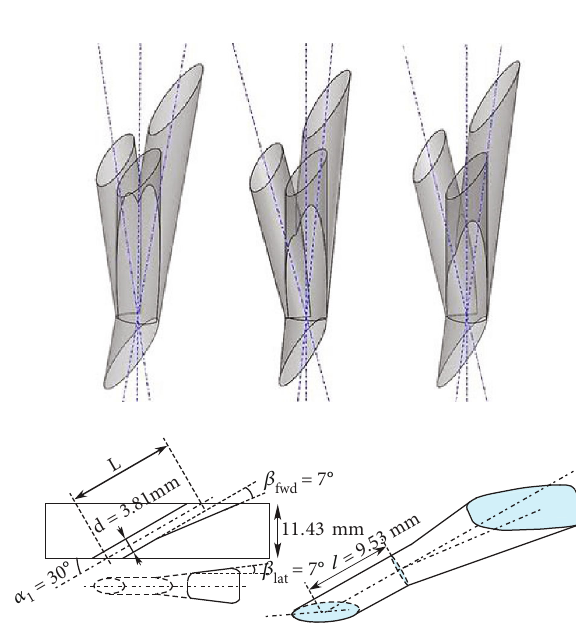
Figure 3: Schematics of the branched fi lm hole geometries (top) and 7 ° -7 ° -7 ° di ff usion hole baseline (bottom).